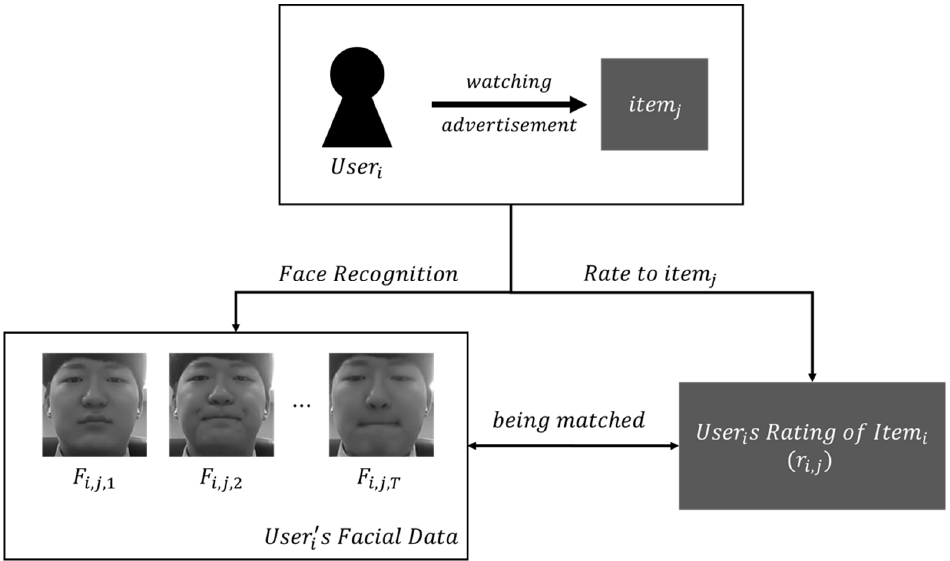
Figure 3. Data collection and data preprocessing.